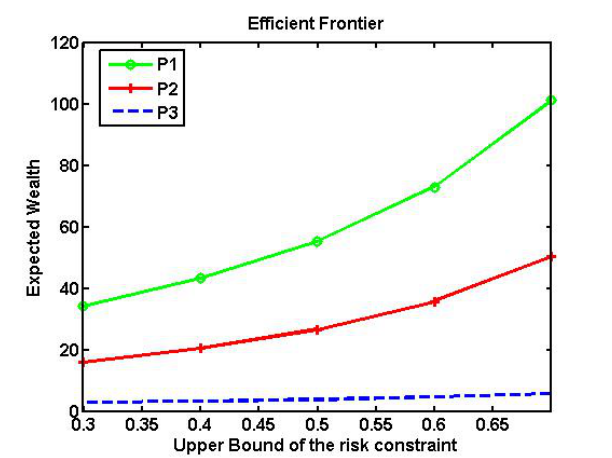
Figure 3. Efficient